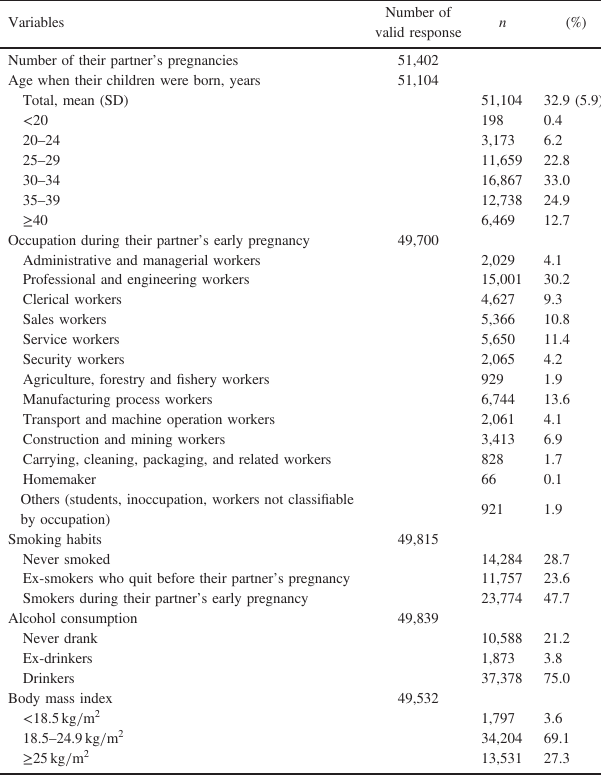
Table 3. Baseline pro fi les of the fathers in the Japan Environ- ment and Children ’ s Study, 2011 – 2014 Variables Number of Number of their partner ’ s pregnancies